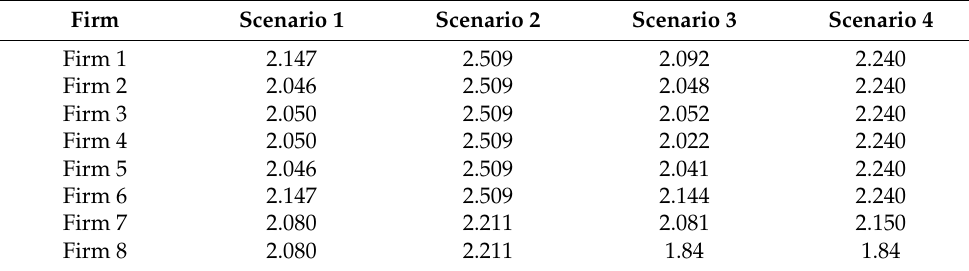
Table 3. Prices of the Nash